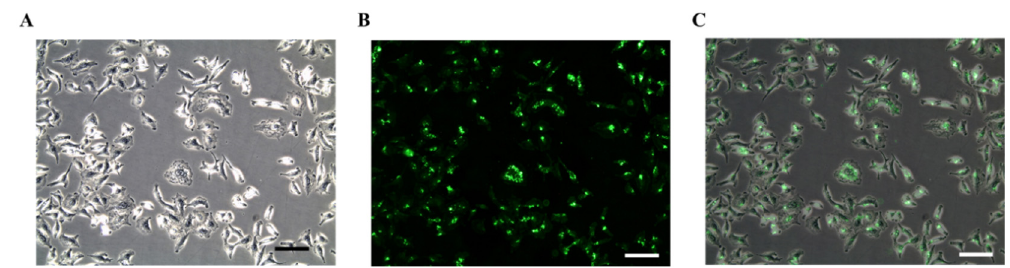
Figure 5. Phase contrast ( A ), fluorescence ( B ), and overlay images ( C ) of A549 cells treated with 0.02 mg/mL biotin-X DHPE followed by the treatment of SA-FITC (scale bar donates 100